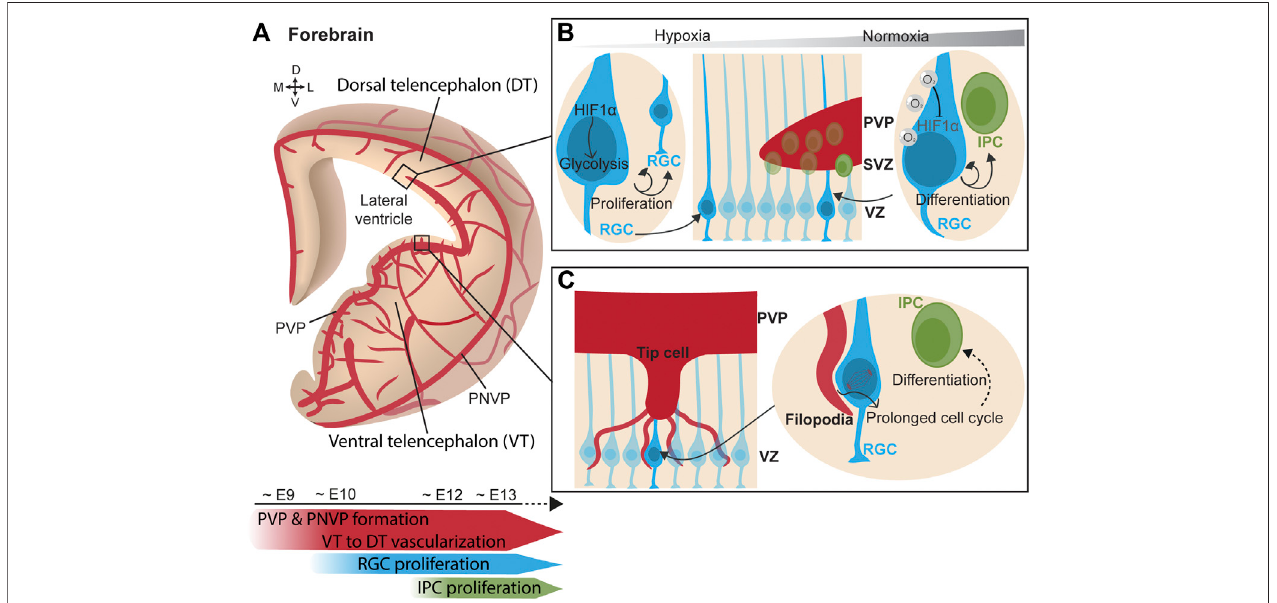
FIGURE 2 | Vasculature in fl uences neurogenesis in the forebrain. (A) (Top) Scheme of a coronal view of the forebrain at the embryonic stage, showing its vascularization from the perineural vascular plexus (PNVP) and the periventricular vascular plexus (PVP) in a progressive manner from the ventral telencephalon towards thedorsaltelencephalon.(Bottom)Timelineofconcurrenttelencephalicembryonicvascularizationandneurogenesis. (B) (Middle)Ventricularzone(VZ)containsalayerof radial glial cells (RGC), which generate intermediate progenitor cells (IPC) that form the subventricular zone (SVZ). (Left) In a poorly-vascularized and hypoxic environment, RGCs express HIF1 α which triggers glycolysis and RGC proliferation. (Right) As oxygenation progresses with increased vascularization, RGC adapt to hypoxia relief. Oxygen supply from blood vessels mediates HIF1 α degradation and promotes RGC asymmetric division generating IPCs. (C) (Left) Tip cells from ingrowing PVP blood vessel extend fi lopodia that directly contact RGC somatas in the VZ. (Right) Endothelial cell fi lopodia adhere to RGC. This direct contact prolongs the mitotic phase of cell division in RGC and favors early neuronal differentiation.